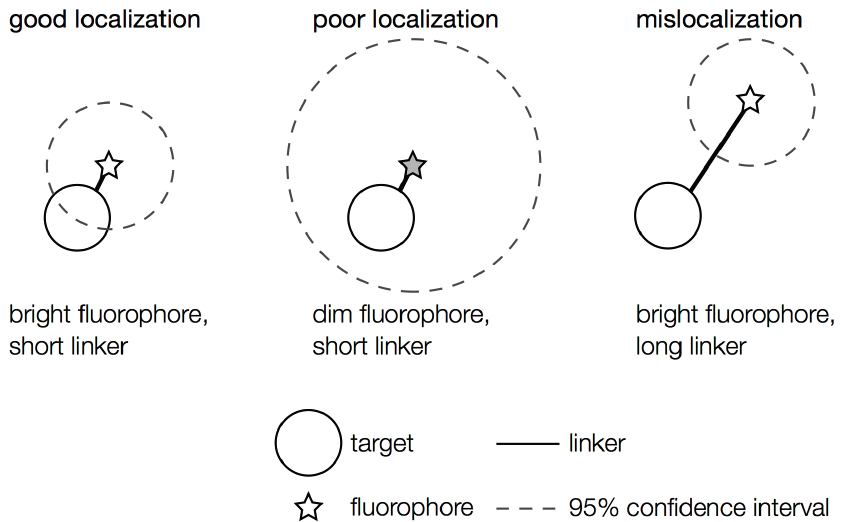
Figure 3. Localization problems arising from dim fluorophores or long linkers. A bright fluorophore that is near the target of interest provides the most precise localization (dashed circle: small confidence interval). Dimmer fluorophores are localized less well (dashed circle: large confidence interval). A precisely localized fluorophore that is far from the feature it is intended to label will not report the actual position